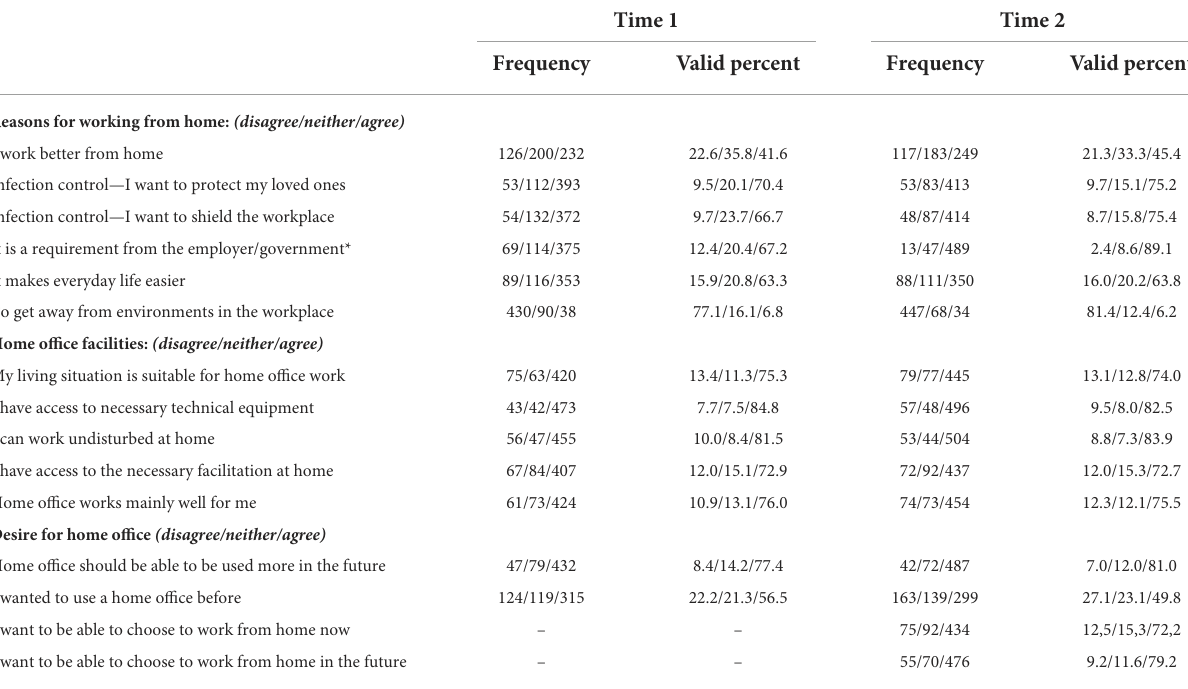
Group differences in job experiences due to COVID-19 were analyzed by univariate General Linear Models (GLM) with the COVID-19 job experience variables as the dependent variable and gender, age, and worksite (home office, hybrid, and workplace) as fixed factors separately. Skewness and kurtosis values were computed to test the normality of the univariate distribution of the data. Skewness and kurtosis values were within the range of normality ( ± 1.96) (Gravetter and Wallnau, 2014). Moreover, frequency analyses were performed by dichotomizing the job experience variables into high